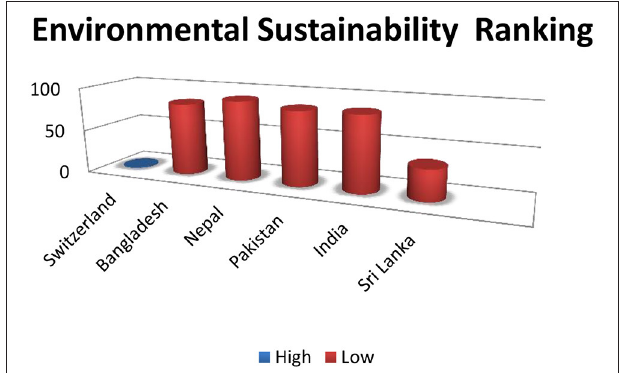
FIGURE 3 | Higher numbers denoting insecurity, compared with Switzerland: